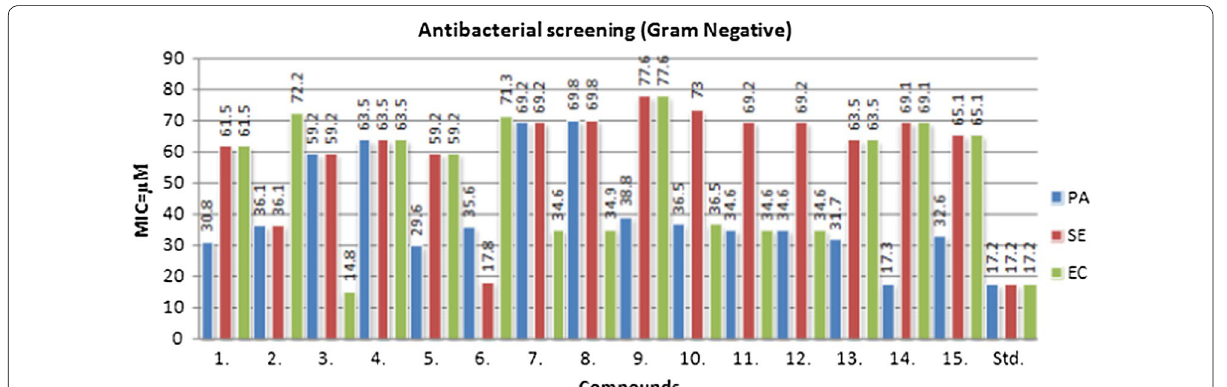
Fig. 4 Antibacterial screening results against Gram negative species